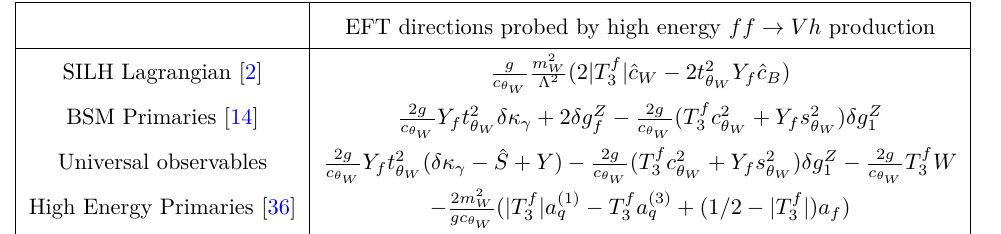
, where f = u L , d L , u R , d R expressed in different Zf and Y f . Note that ˆ c W = 3